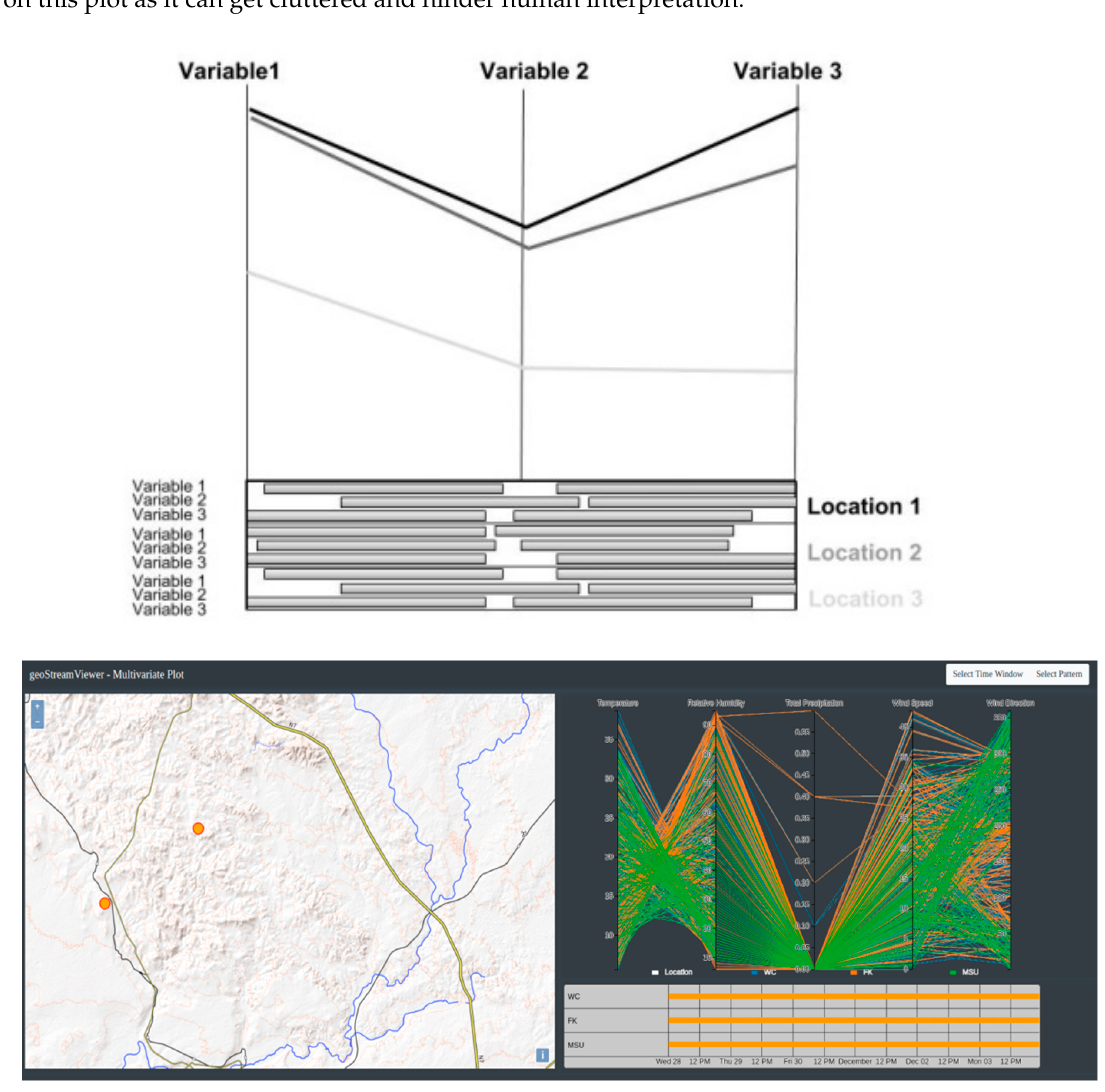
Figure 8. ( a ) Conceptual design of the combined parallel coordinates time series plot, and ( b ) implementation based on observed weather at various locations.